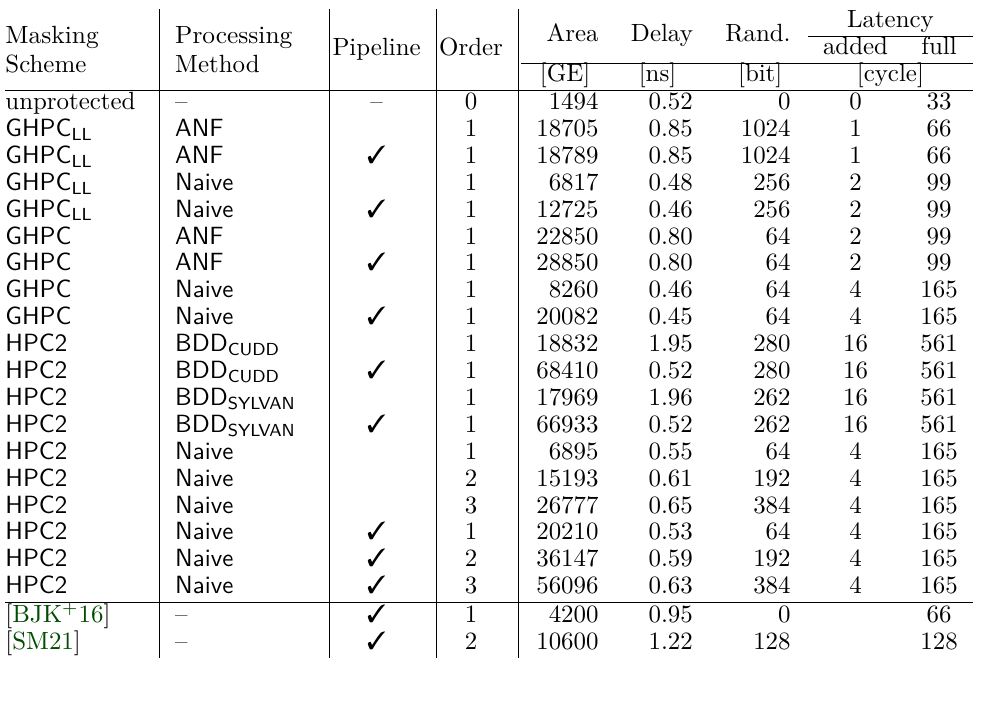
Table 10: Synthesis results, Skinny-64-64 round-based encryption function.